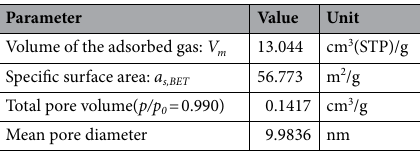
Table 2. Summary of results of BET test for the CoFe 2 O 4 MNPs.